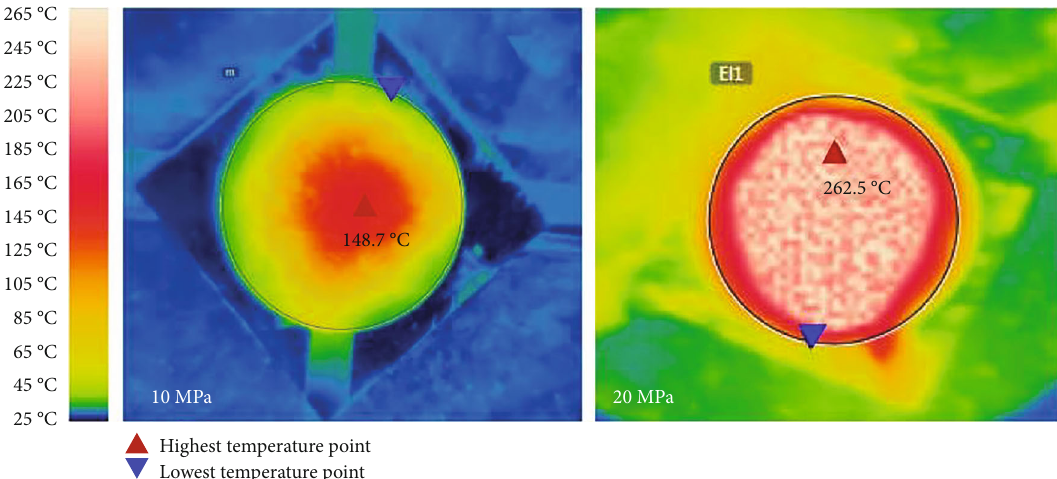
Figure 9: Infrared thermal radiation distribution on granite loading surface after UHF impact subjected to the con fi ning pressure of 10 and